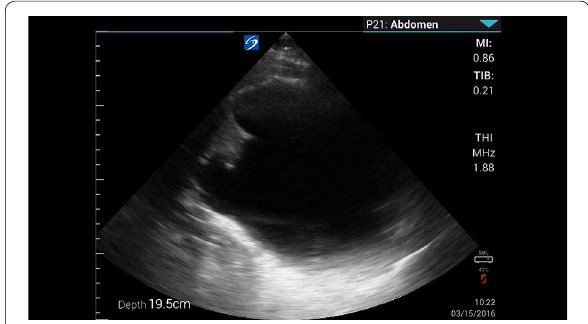
Fig. 1 Ultrasound of the patient’s right upper quadrant. There is a large anechoic cystic structure with adjacent smaller cystic structures; these smaller cystic structures are actually the dilated biliary tree.